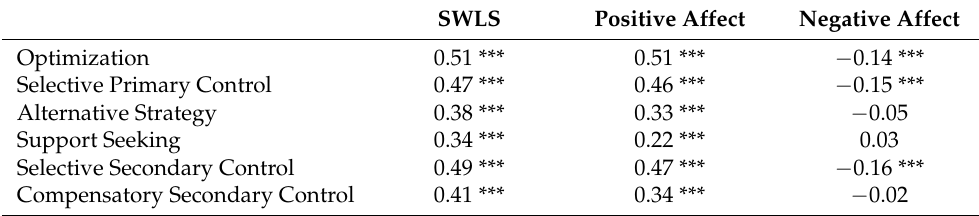
Table 7. Pearson’s Correlations between OPS factor scores and Well-beings.